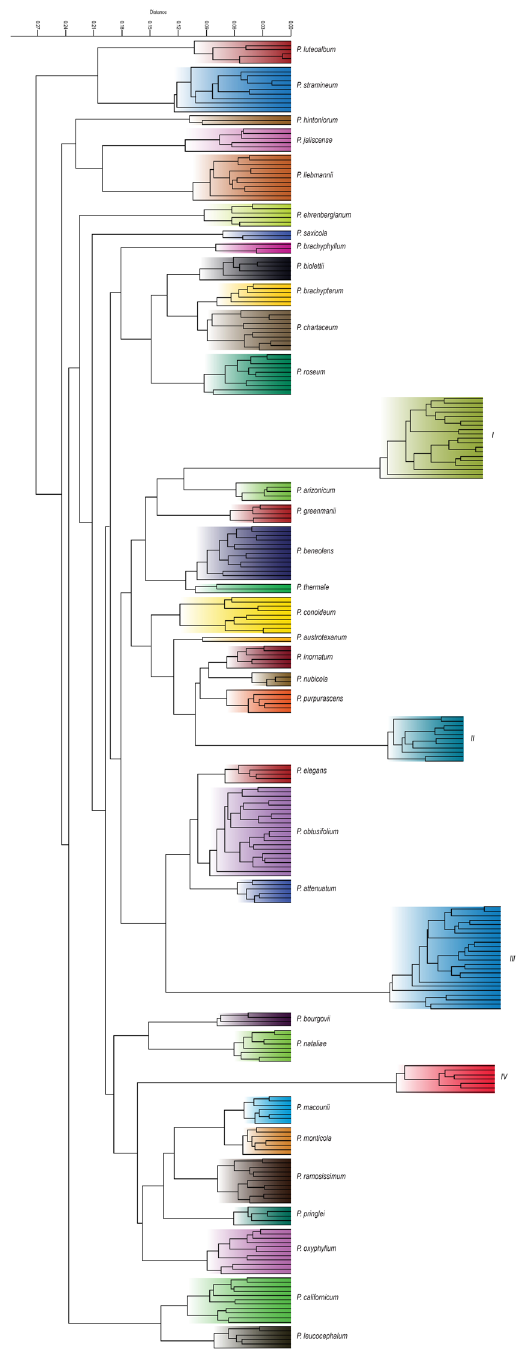
Figure 1a. UPGMA cluster analysis of the whole set of 297 specimens of the North American species of Pseudognaphalium , using a matrix calculated from 36 characters (Gower’s coefficient of similarity). I: P. canescens and P. microcephalum ; II: P. semilanatum and P. semiamplexicaule ; III: P. helleri and P. micradenium ; IV: P. crenatum and P.